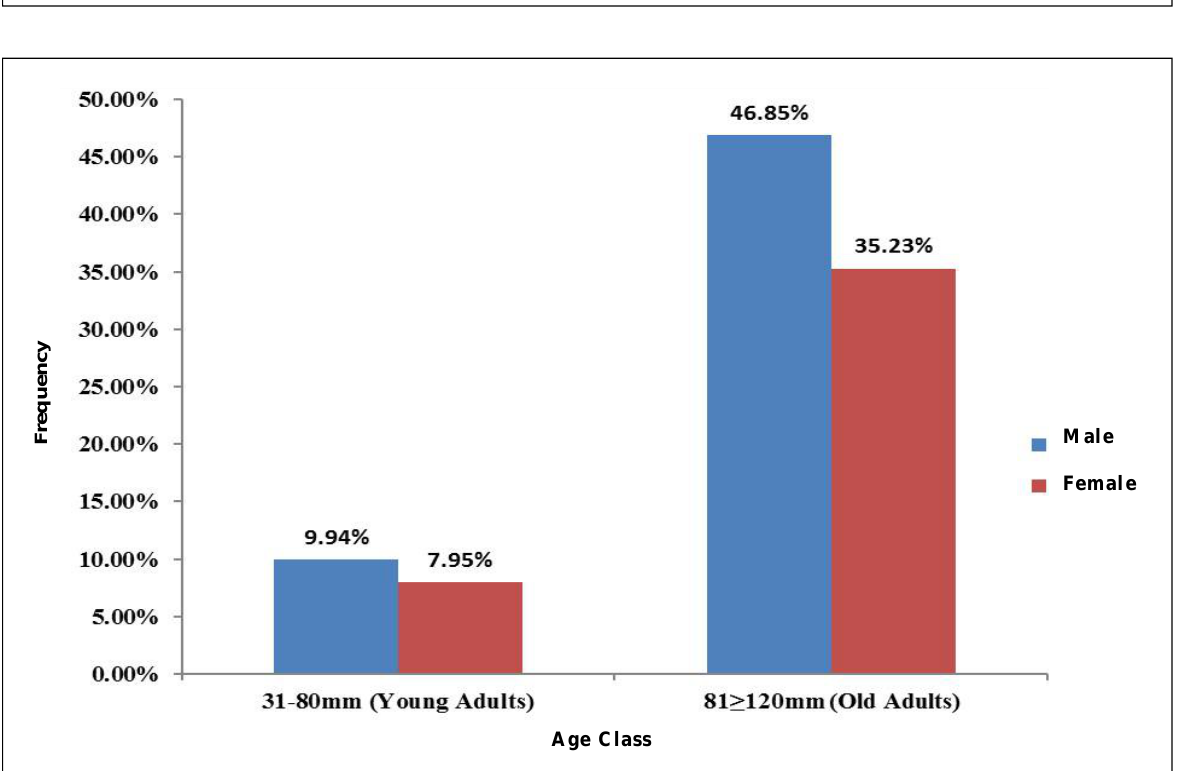
Figure 2: Age class structure of population of M. vollenhovenii collected from volta river basin channel,